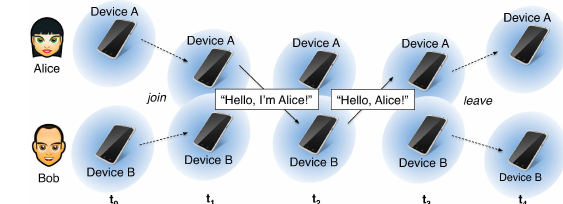
Figure 1: Example of NearTweet—a chatting mobile app—running on a simple encounter network. The appli- cation screen is shown on the left, and the network topology evolution on the right.